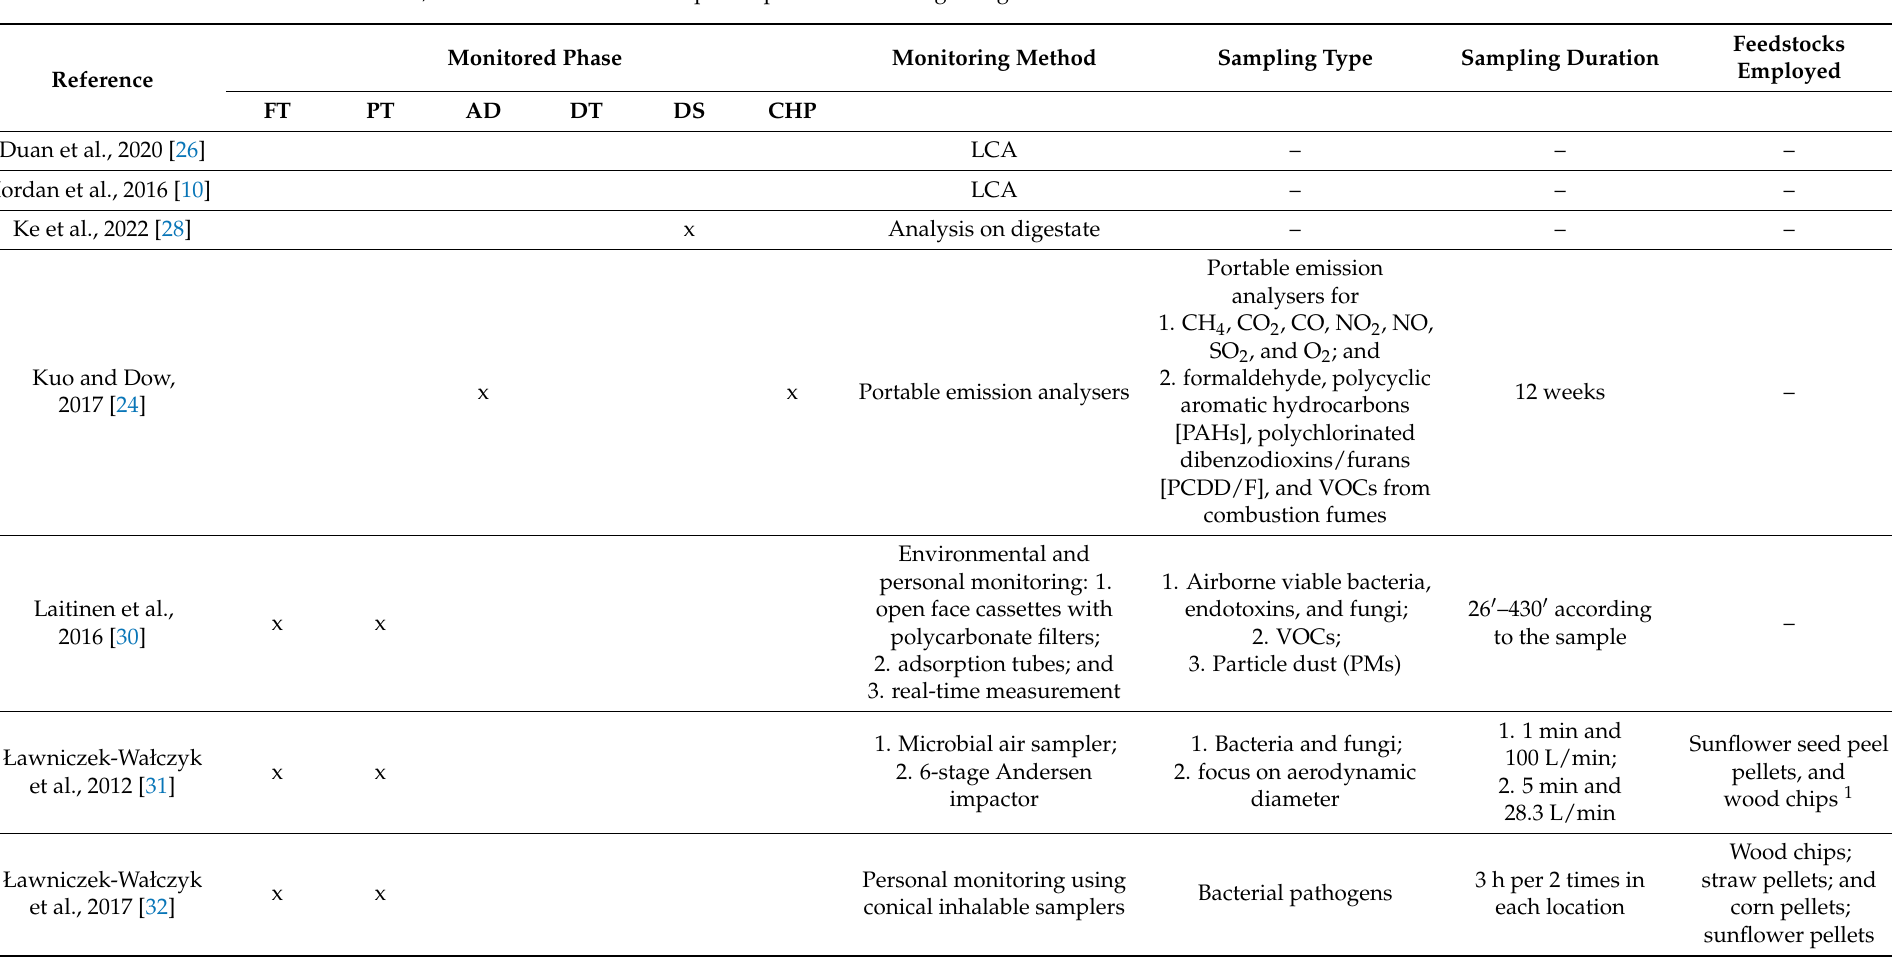
Table 6. Overview of the monitoring setup in the analysed plants. FT: Feedstock transport—including operation of handling within the plant facilities before initial treatment; PT: Pre-treatment—initial phases before anaerobic digestion; AD: Anaerobic digestion—sequence of processes by which microorganisms break down biodegradable material in the absence of oxygen; DT: Digestate treatments—operations for processing digestate; DS: Digestate storage—storage of digestate before distribution; CHP: Combined heat and power production through